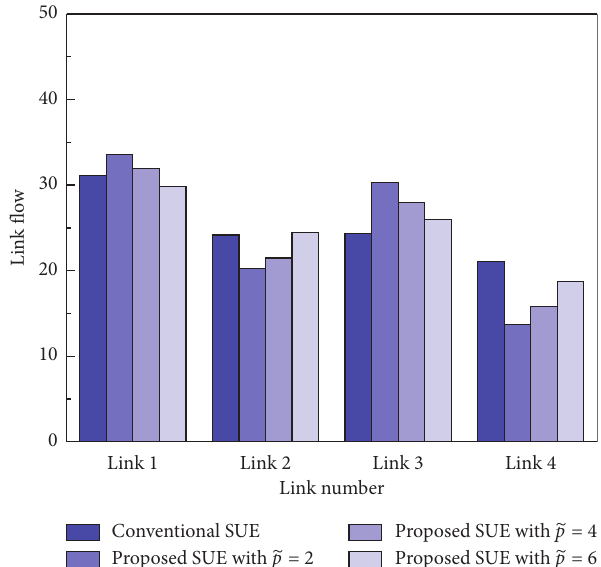
Figure 4: Comparison of equilibrium link flow patterns between the proposed and conventional probit-based SUE